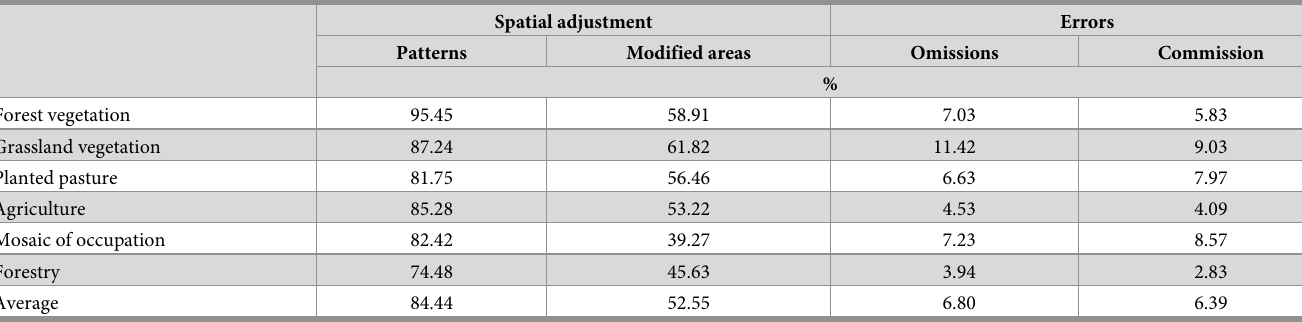
Table 5. Percentage of spatial adjustment and errors.